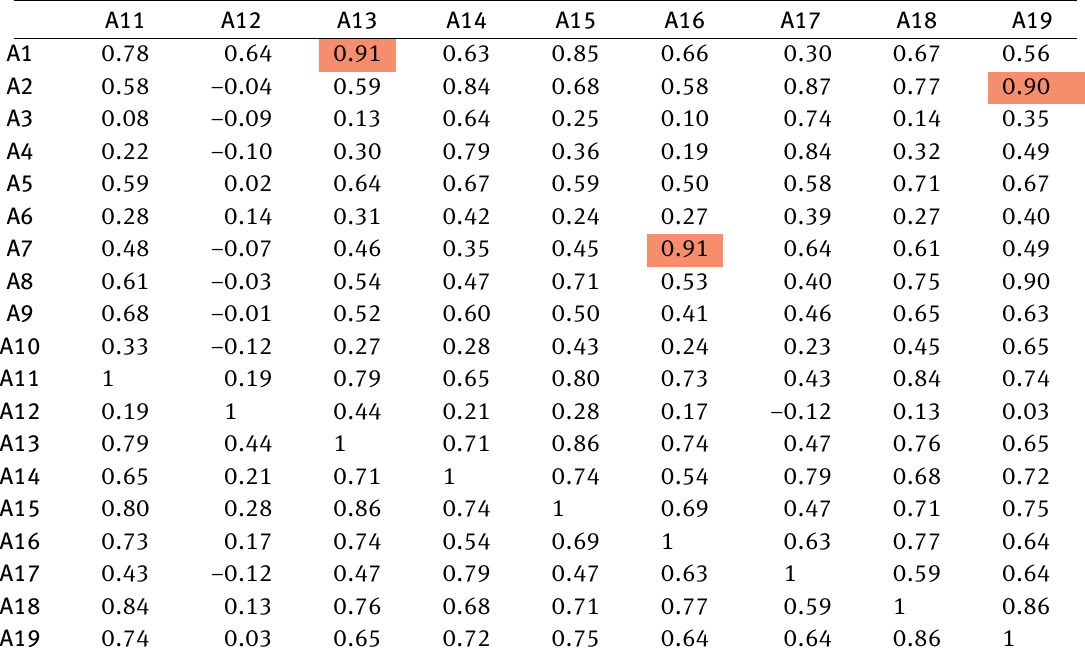
Table 5: Empirical correlations between original losses in adjacent areas, part II